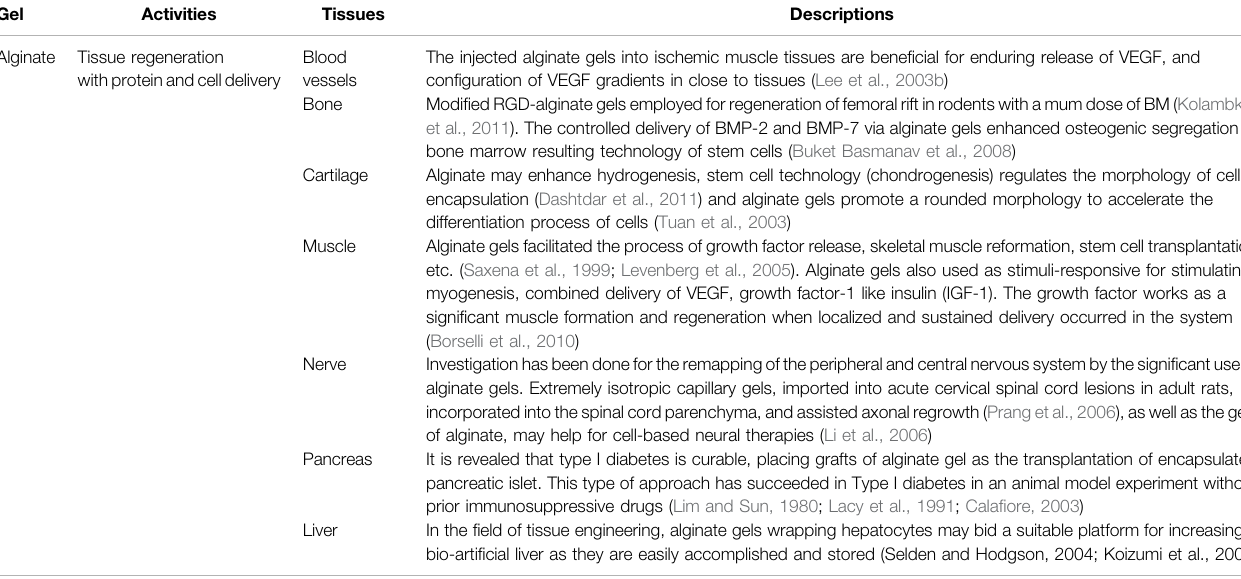
TABLE 2 | Application of alginate gels in the tissue regenerations. Gel Activities